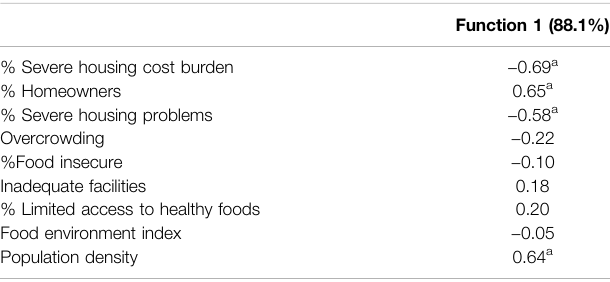
TABLE 11 | Means for housing/food variables by latent Function 1 (88.1%)